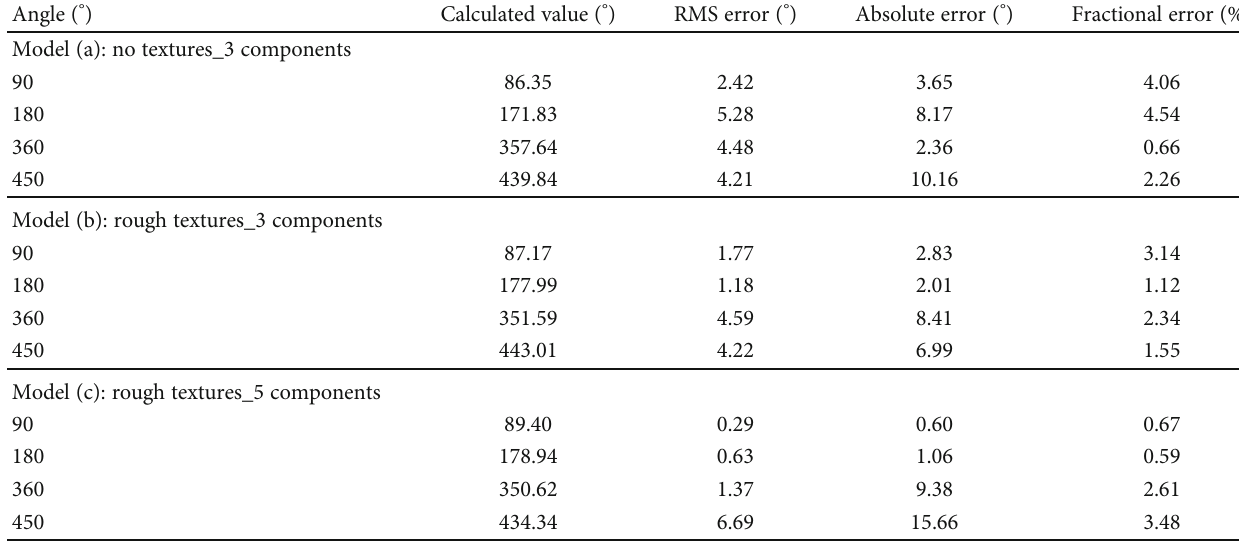
Table 1: Calculated values and errors of the three models under di ff erent rotation angles (10 frames per degree). Angle ( ° )